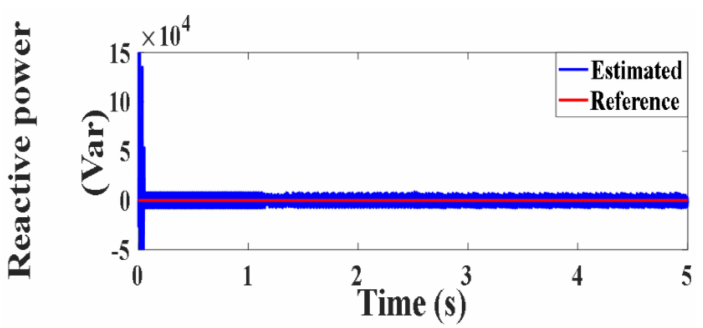
Figure 60. Reactive power under PVC (var).